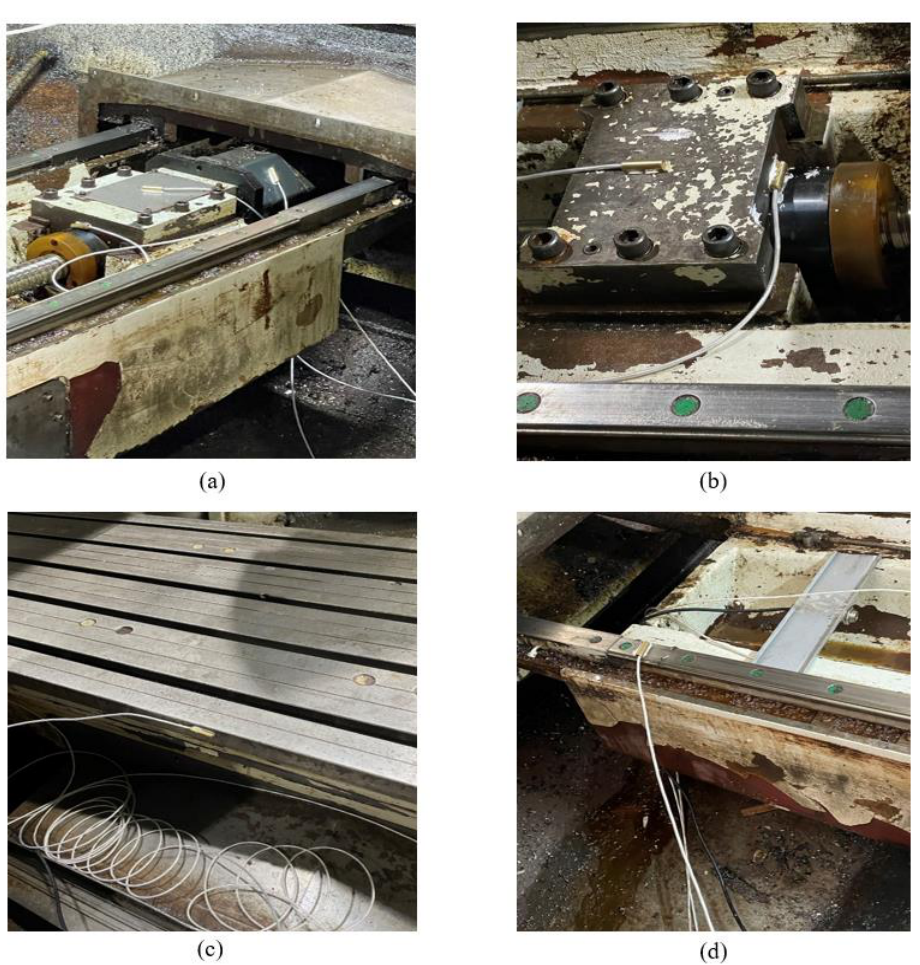
Figure 7. Some site diagrams of temperature measuring points layout and data collection: ( a ) Motor, Motor coupling, Right screw seat, ( b ) Left screw seat, ( c ) Workbench, and ( d ) Left guide rail.